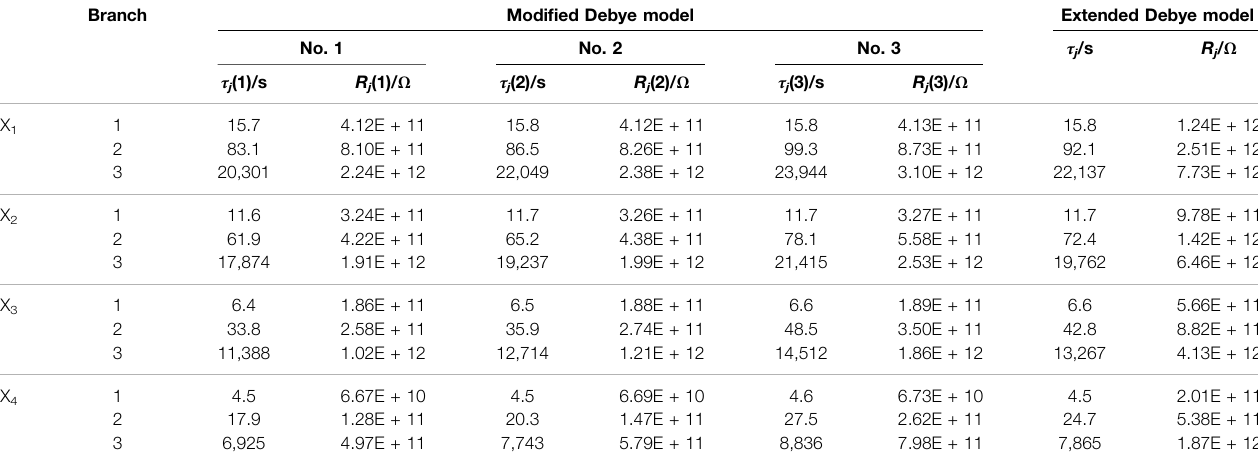
TABLE 3 | Parameters of the modi fi ed Debye model and extended Debye model for X 1 , X 2 , X 3 , and X 4 samples.